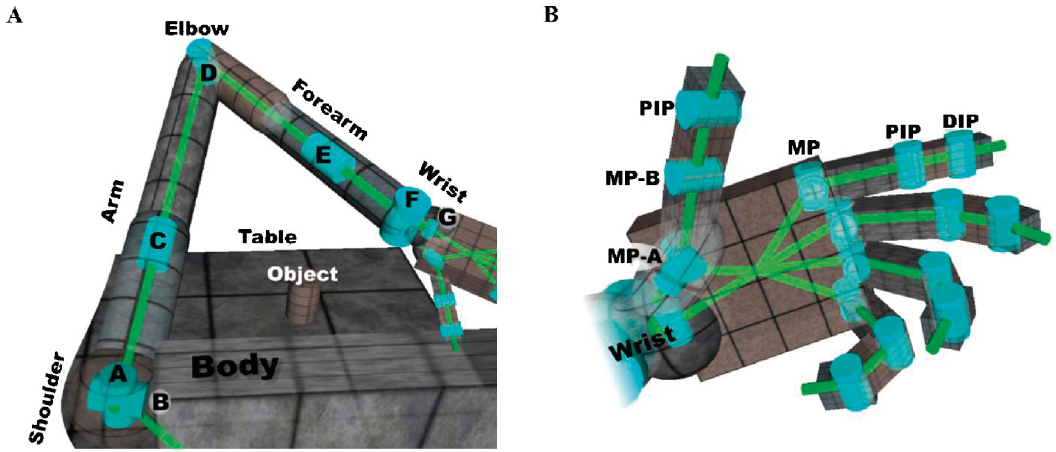
Figure 1. The kinematic chain of the arm and of the hand . Cylinders represent rotational DOFs. The axes of cylinders indicate the corresponding axis of rotation. The links amongst cylinders represents the rigid connections that make up the arm structure.